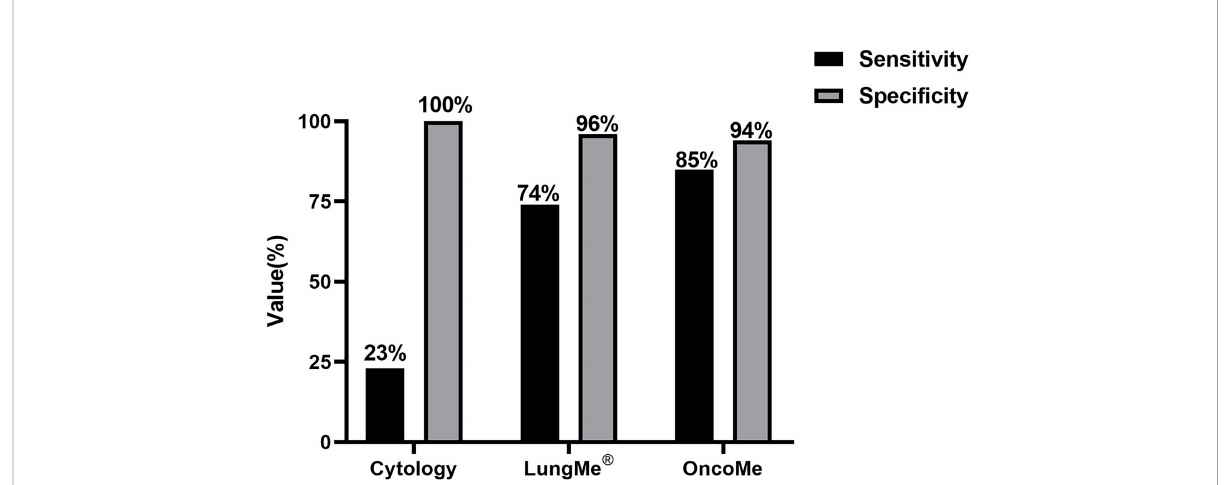
FIGURE 3 Comparison of cytology and the gene methylation panels LungMe ® (SHOX2+RASSF1A) and OncoMe (SHOX2+RASSF1A+SEPTIN9+HOXA9) for the differential diagnosis of pleural effusion.